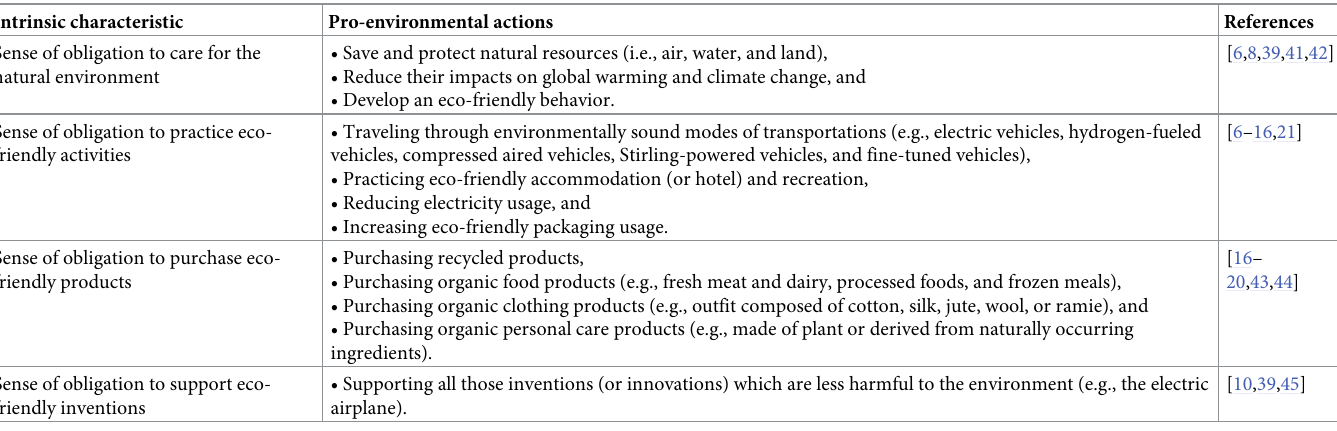
Table 1. Intrinsic characteristic eliciting pro-environmental